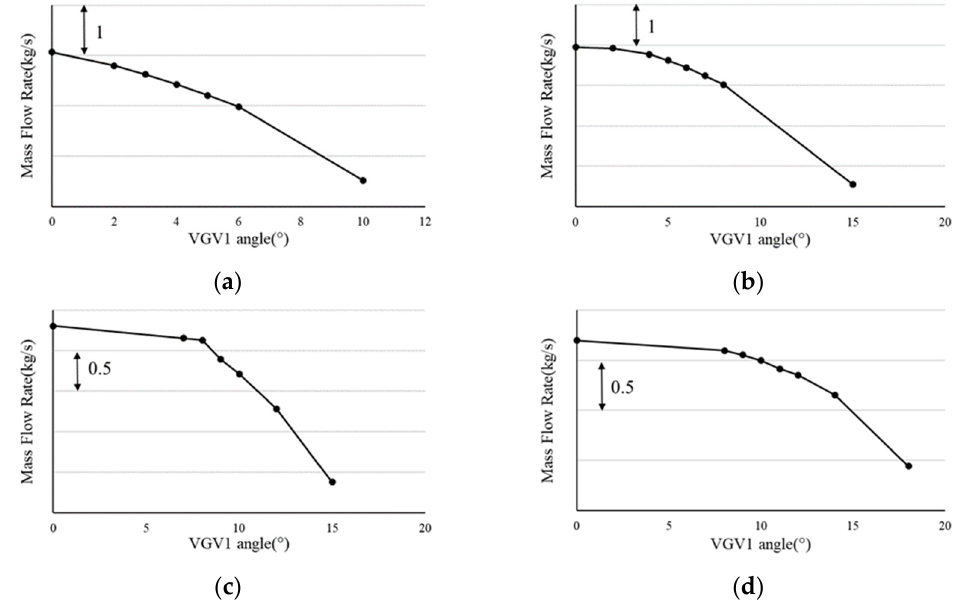
Figure 9. The relationship between mass flow and the VGV1 turning angle. ( a ) IGV = 10 ◦ ; ( b ) IGV = 20 ◦ ; ( c ) IGV = 30 ◦ ; ( d ) IGV = 40 ◦